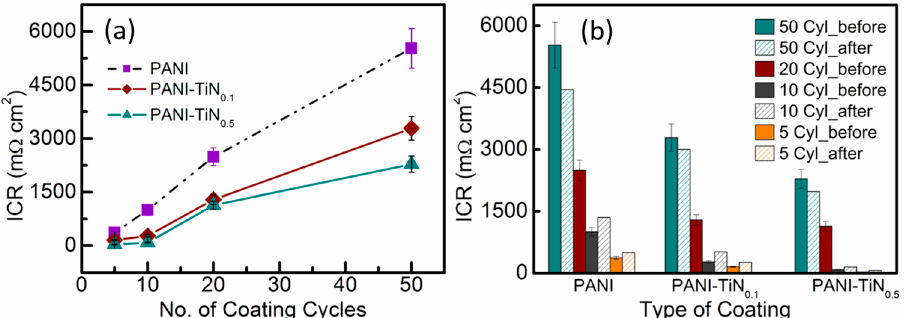
Figure 3. ( a ) ICR values of the three coatings with respect to increasing CV coating cycles, and ( b ) ICR values for the three types of coatings before and after corrosion tests.